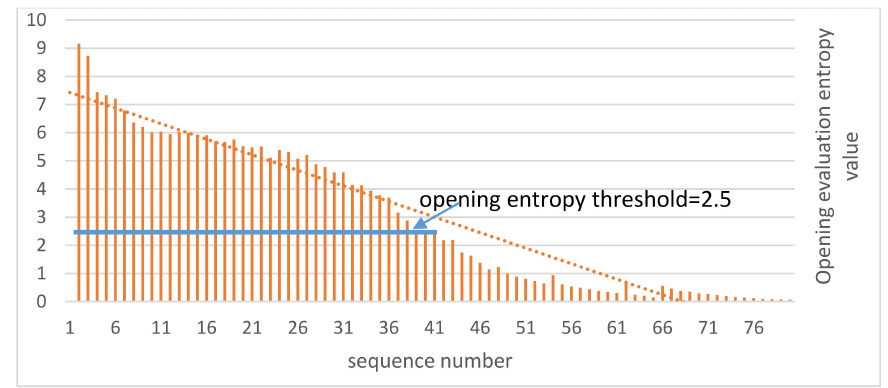
Figure 6. Opening evaluation entropy value.